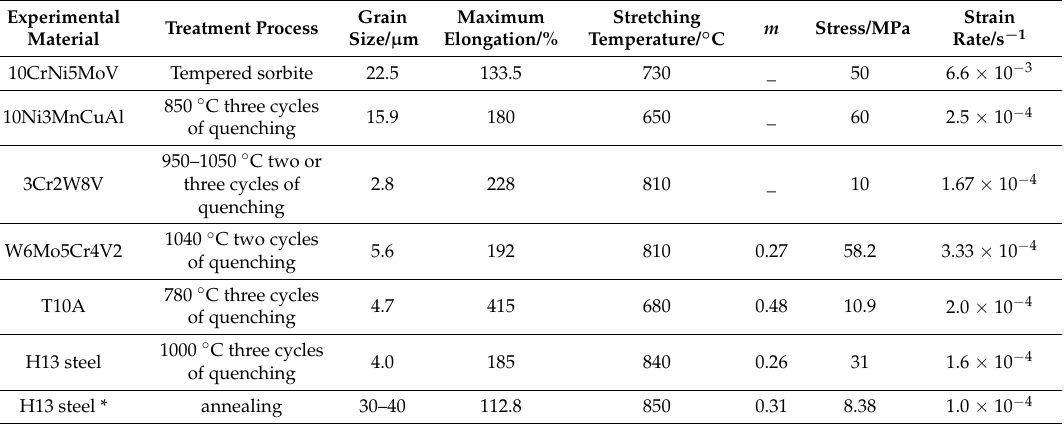
Table 2. Comparison of various steel parameters [16–20]